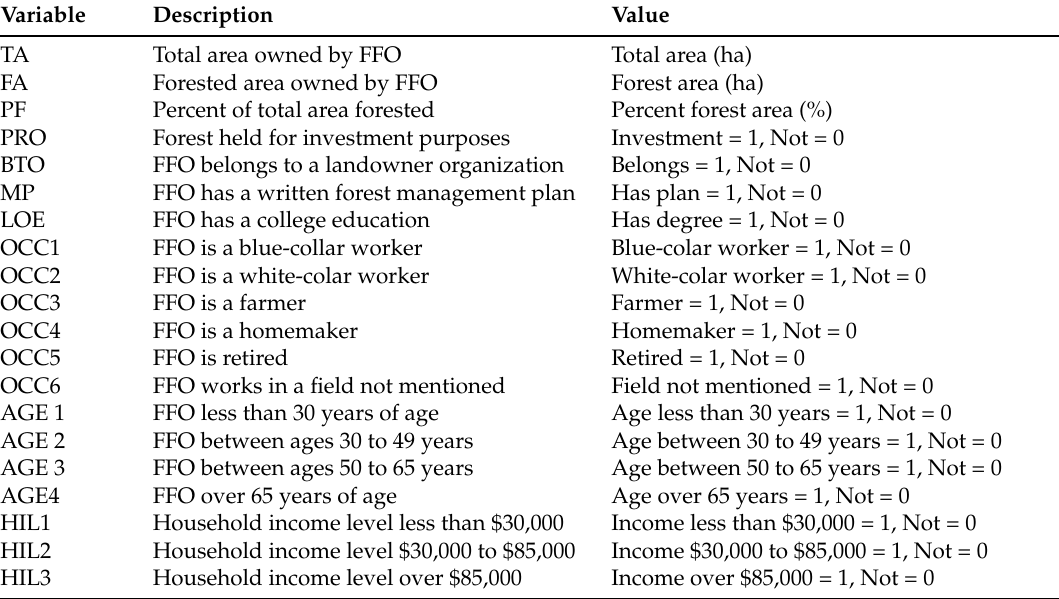
Table 2. Summary of independent